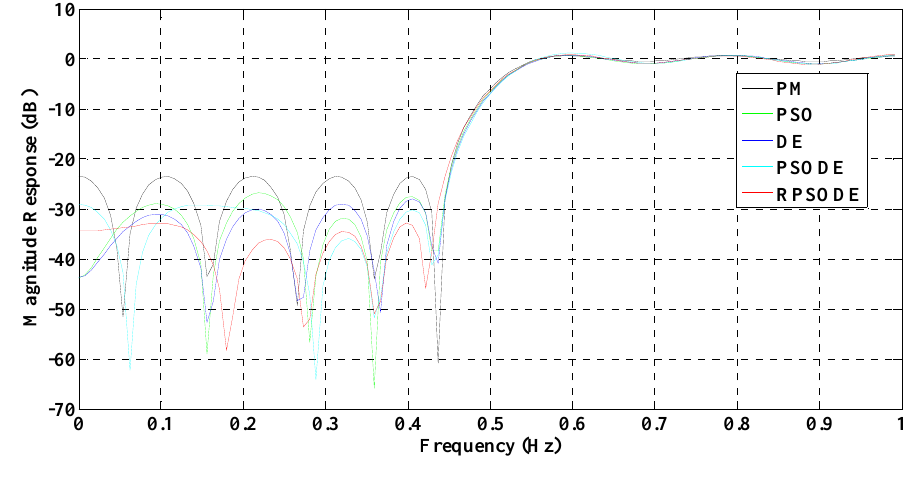
Figure 2: dB plots for the FIR LP filter of order 20.